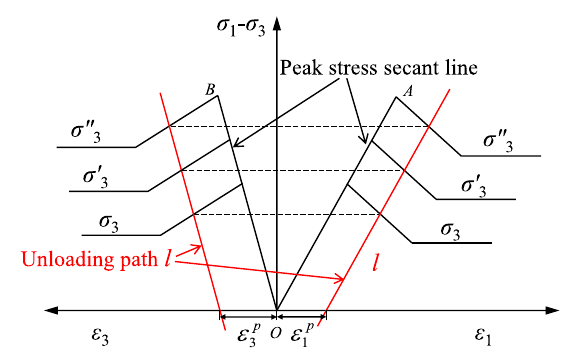
Fig. 10 Post-peak rock strain-softening plastic strain–stress relation- ship